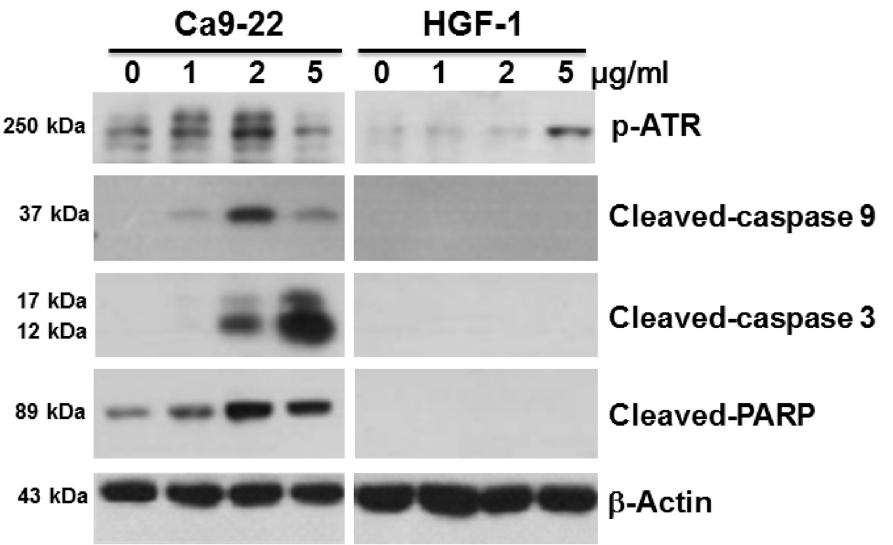
Figure 8. Treatment with 4 b HWE induced different apoptosis-related protein expressions in oral cancer Ca9-22 cells and in normal oral HGF-1 cells. Cells were treated with 0, 1, 2, and 5 m g/ml 4 b HWE for 24 h. Apoptosis signaling proteins, such as p-ATR, and cleavage of pro- caspase 9, pro-caspase 3 and PARP were detected. The b -actin was used as an internal control. Each blot represents an independent experiment performed in triplicate.